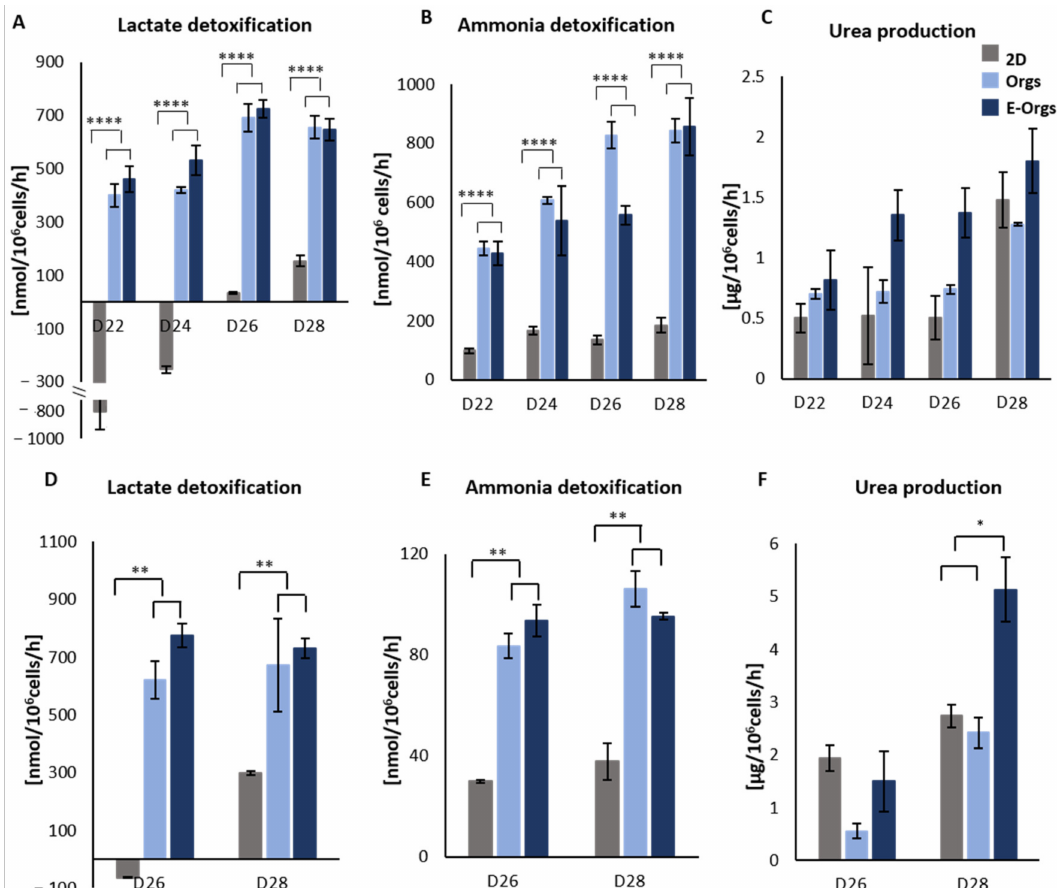
Figure 4. Detoxification abilities and urea production of iHeps. ( A – C ) Lactate and ammonia detox- ification and urea production under moderate pathological conditions, respectively. Histograms represent mean ± SD ( n > 10). ( D – F ) Lactate and ammonia detoxification and urea production under ultra-pathological conditions, respectively. Histograms represent mean ± SD ( n > 5). p < 0.0001 (****), p < 0.01 (**) and p < 0.05